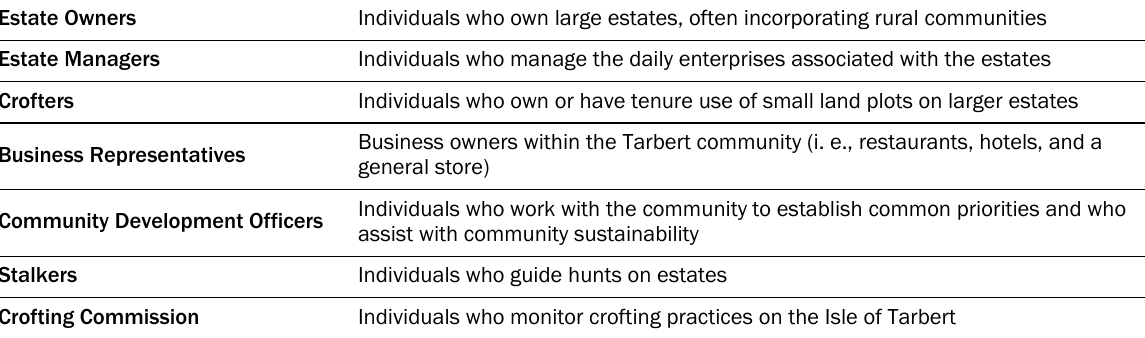
Table 1: Stakeholder Roles and Corresponding Definitions Estate